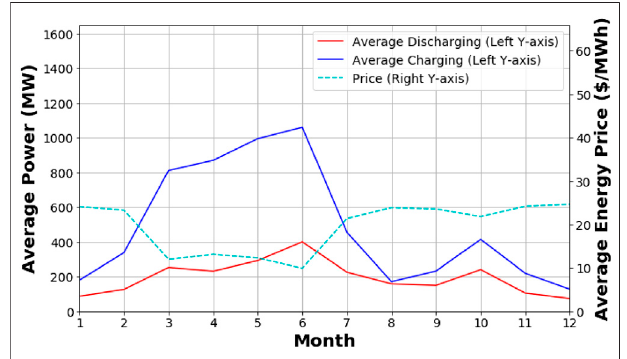
FIGURE 12 | Average monthly discharge, charging, and received price pro fi les for a 2,000 MW, 40% round-trip ef fi ciency, and 1-month duration energy storage device in 2050.